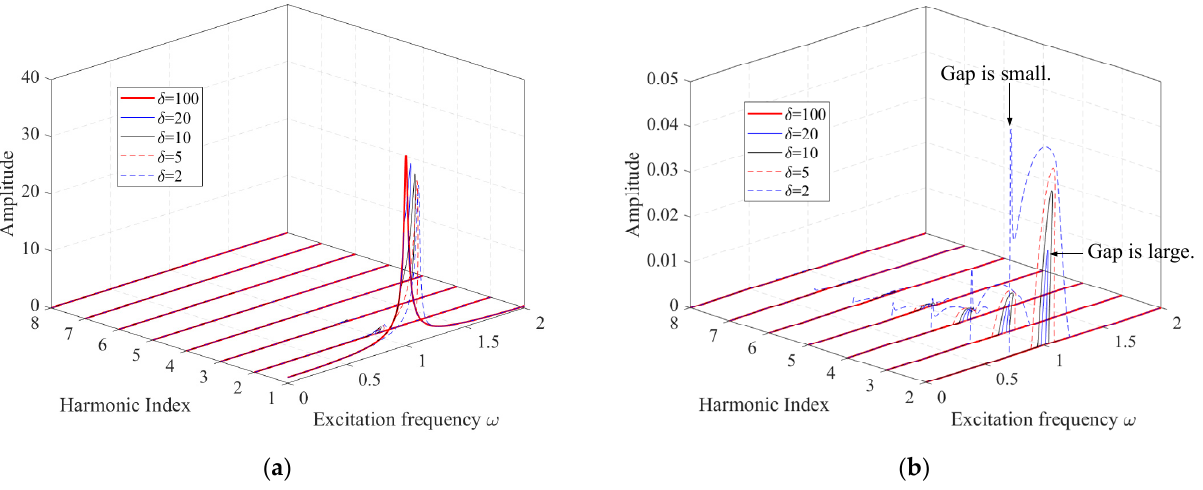
Figure 5. Amplitudes of super-harmonic terms of Dof-1: ( a ) absolute value; ( b ) relative Value.